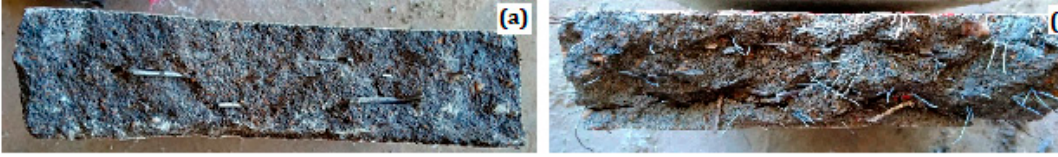
Figure 13. Appearance of failure plane. ( a ) two layer mesh ( b ) three layer mesh.